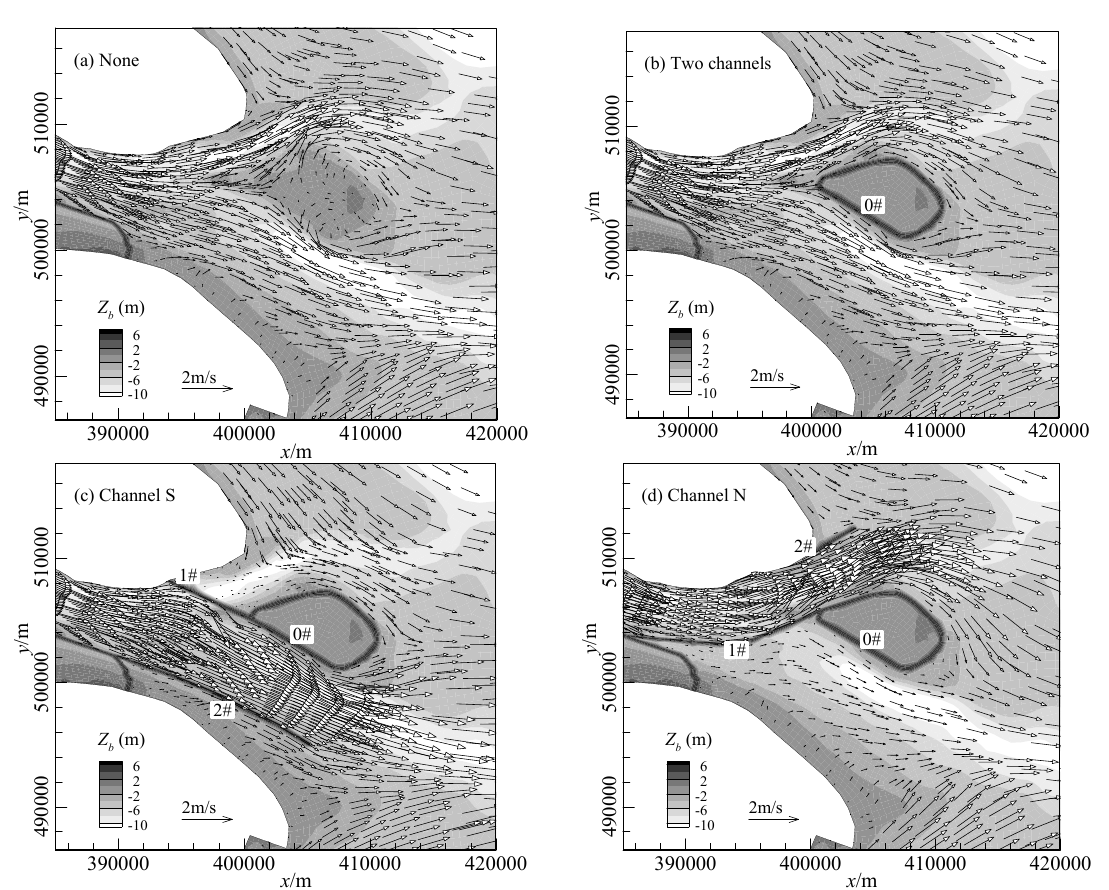
Figure 10. Velocity fields under different designs at ebb-tide ( t = 18 h).